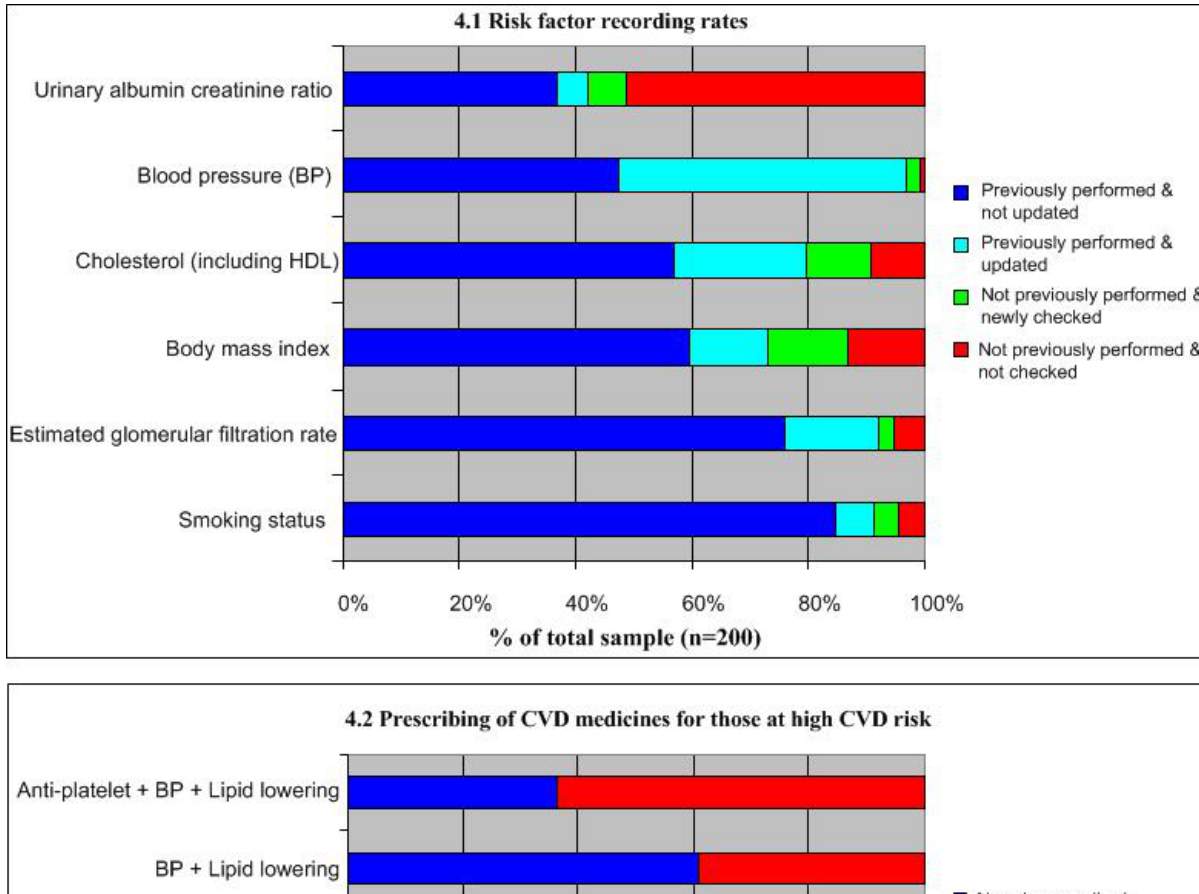
Figure 4. CVD management practices before and after a consultation involving the CDS